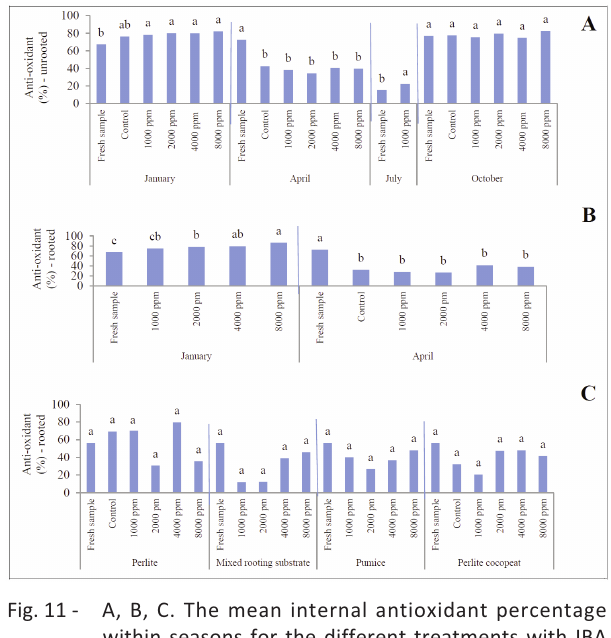
Fig. 11 ­ A, B, C. The mean internal antioxidant percentage within seasons for the different treatments with IBA for rooted and unrooted cuttings. Mean values for the same letter were not significantly different at the 0.05 level according to the LSD test. 540 stem cuttings in each season were planted. For treatments not repre­ sented in the figure, all the cuttings